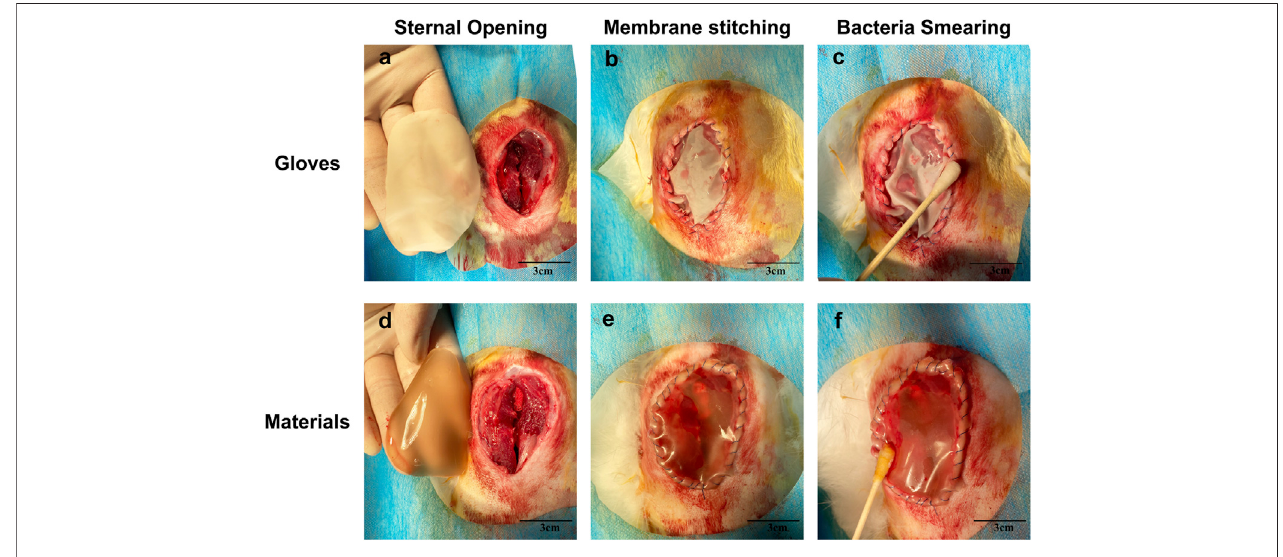
FIGURE 7 | (A – C) Performing DSC with surgical glove sheet, and (D – F) with materials.